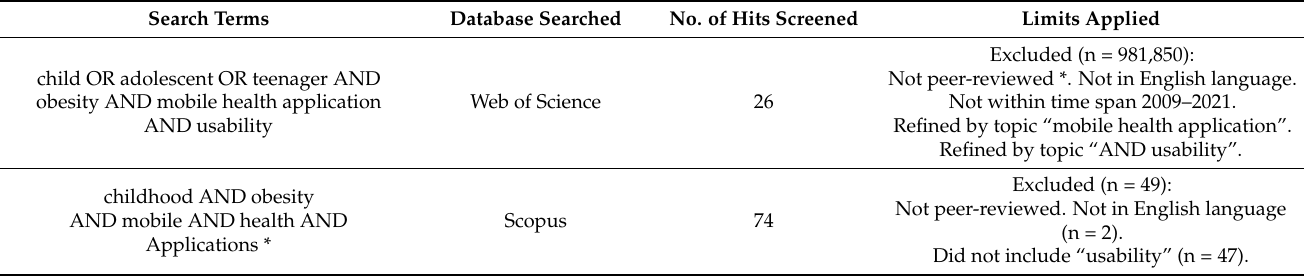
Table A1. Search diary outlining completed searches and articles accessed and reviewed for the literature